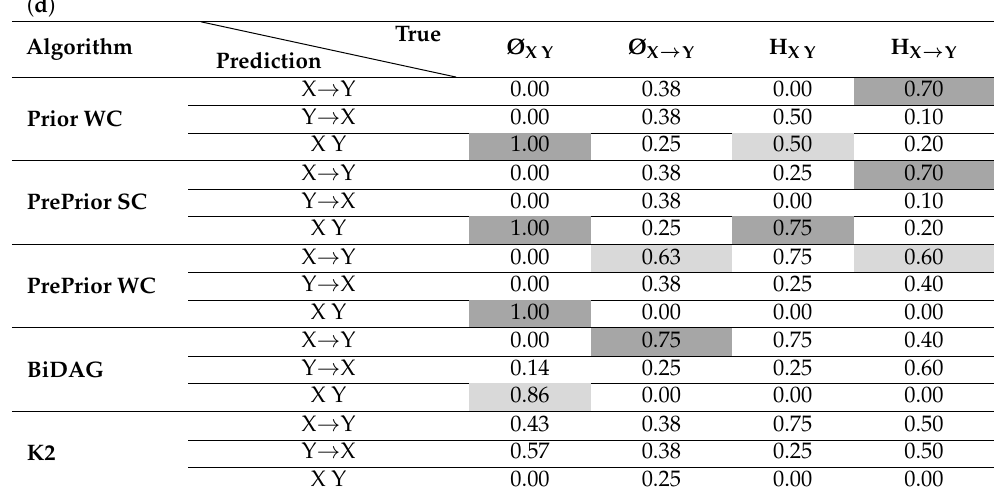
Table 11. Algorithms’ most probable prediction rates by four causal pairwise relationships with the order weight. (a) Dataset for Sparse 9 variable with 50 cases (D50S9). Dark shaded cells represent the best prediction of the correct causal relationship; Bright shaded cells represent the second best prediction of the correct causal relationship. (b) Dataset for Close 9 variable with 50 cases (D50C9). Dark shaded cells represent the best prediction of the correct causal relationship; Bright shaded cells represent the second best prediction of the correct causal relationship. (c) Dataset for Sparse 9 variable with 1000 cases (D1KS9). Dark shaded cells represent the best prediction of the correct causal relationship; Bright shaded cells represent the second best prediction of the correct causal relationship. (d) Dataset for Close 9 variable with 1000 cases (D1KC9). Dark shaded cells represent the best prediction of the correct causal relationship; Bright shaded cells represent the second best prediction of the correct causal relationship.